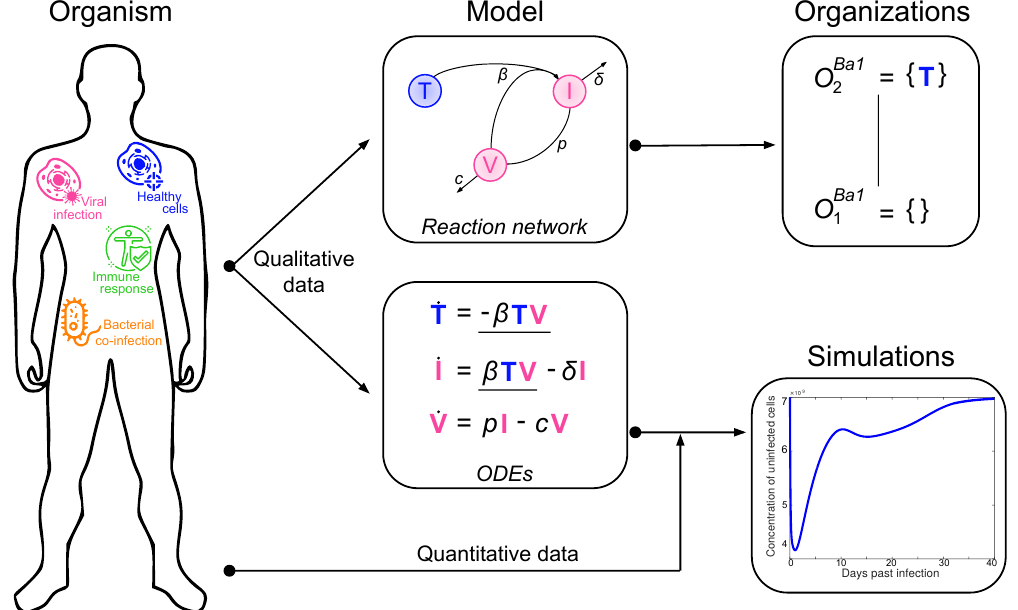
Figure 1. Relation between measured data, ordinary differential equations (ODE) model, and hierarchy of